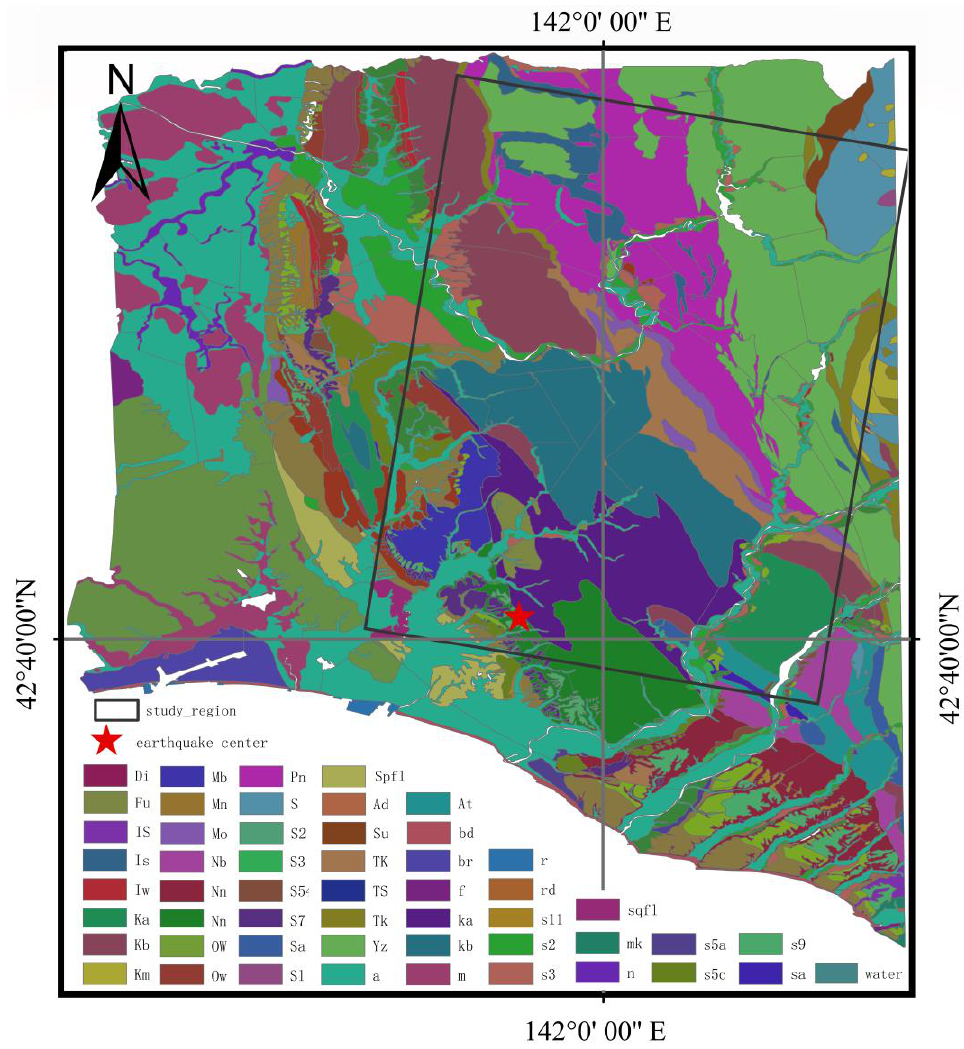
Figure 2. Geological map resvised by authors form Ozkai and Komatsubara [25]. Table 1. Basic parameters of SAR datasets.